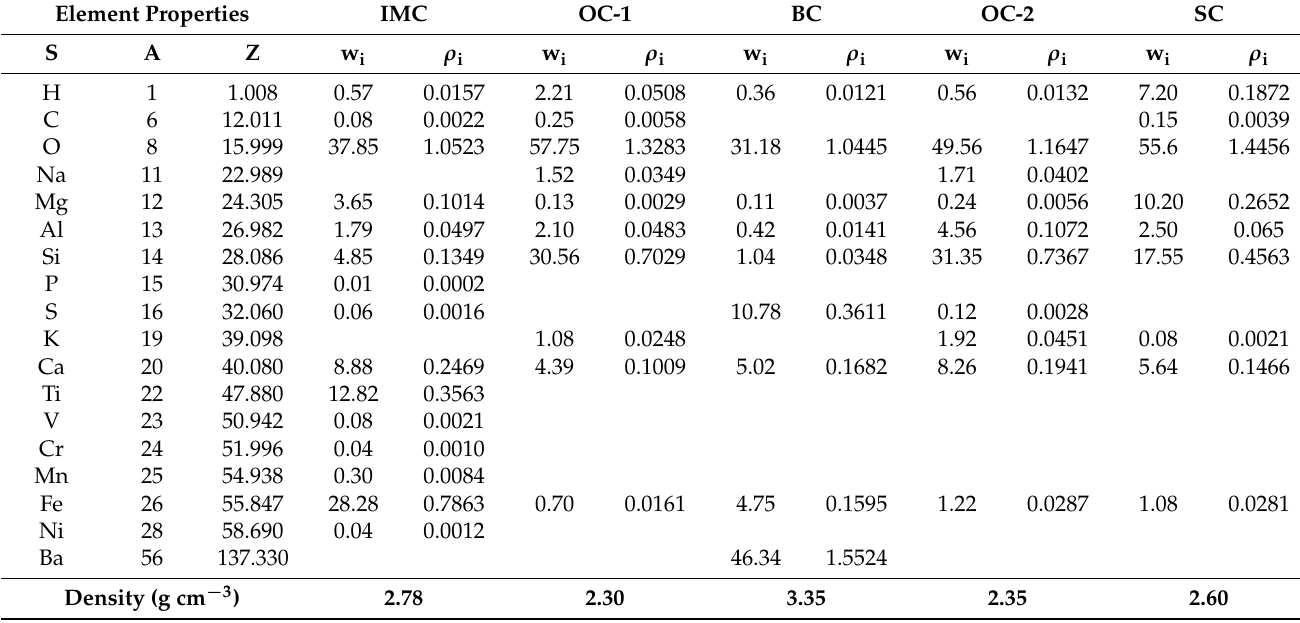
Table 1. The elemental composition, atomic and mass numbers, fraction by weight, partial density, and density of the concrete materials used in the present